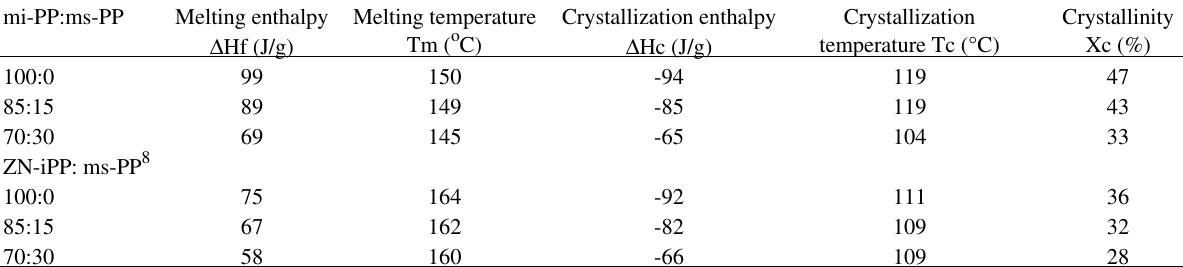
Table 4. Influence of metallocenic s-PP addition on the crystallinity of i-PP. mi-PP:ms-PP